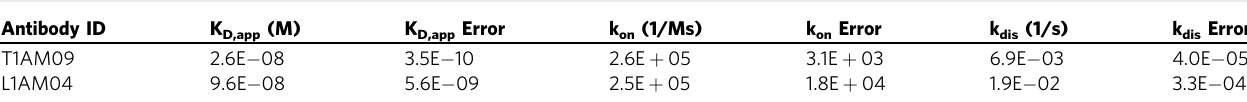
Table 1 Binding kinetics of mAbs analyzed by Bio Layer